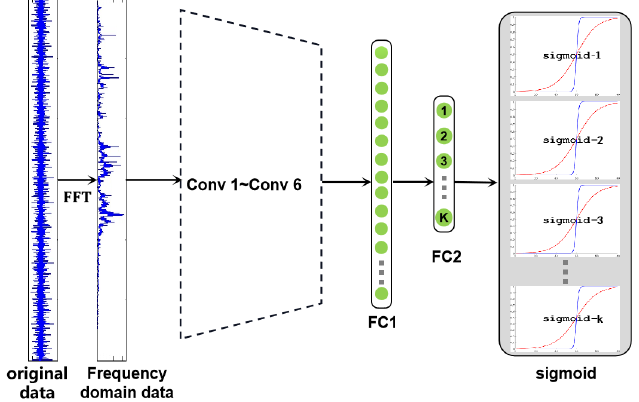
Figure 2. Block diagram of the OS-CNN model. The parameters of each convolution layer and pooling layer are shown in Table 1. Table 1. Details of the feature extractor used in the